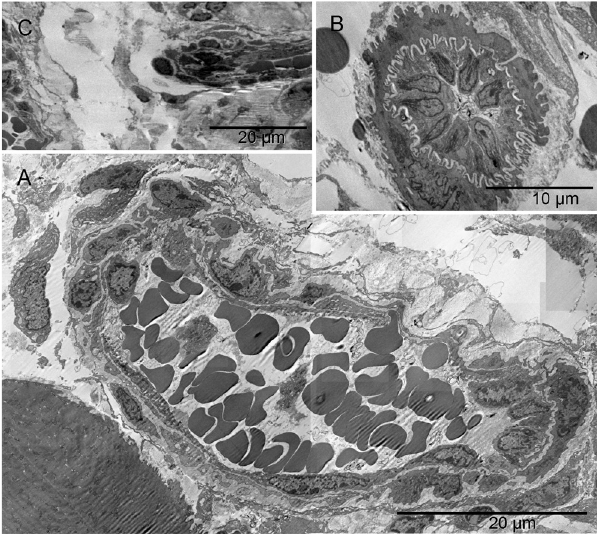
Figure 11. Morphogenesis of an artery (I). Forming lumen of the emerging vasculature fragment shown in [ A ] was occupied by free erythrosomes and platelets. That “vasculature piece” was not a vessel yet because it included blood elements that were being generated simultaneously with the vessel wall. The wall was incomplete at the time of image capturing. Structural differences along the circumference of the future lumen included a gap on the left side. Such lack of continuity and the irregular forms of erythrosomes also indicated that the forming vessel was not yet a part of the circulation. In that region, cells other than endothelial cells were recognizable, namely chromaffin cells and megakaryocytes at the outer side although their products (platelets) accompanied the erythrosomes in the lumen. The right side of the vessel wall was structurally the most advanced; it consisted of ECs uncharacteristically non-flattened. The shape of their nuclei and corrugation of the basement membrane between those cells and supporting pericyte suggested a potential for physical expansion. Such wavy basement membrane likely contained elastic fibers. The image in [ B ] could have been from a similar region cut in a perpendicular plane with regard to that in [ A ]; nuclei of the centrally located ECs had their radial sinuses oriented towards the basement membrane. That too could facilitate the expansion of the vessel. ECs in the middle part of the main image [ A ] were flattened; in the upper side one could see an erythrosome passing through. The spatial relationship between structures shown in [ A ] and in Figure 13 is demonstrated in [ C ].